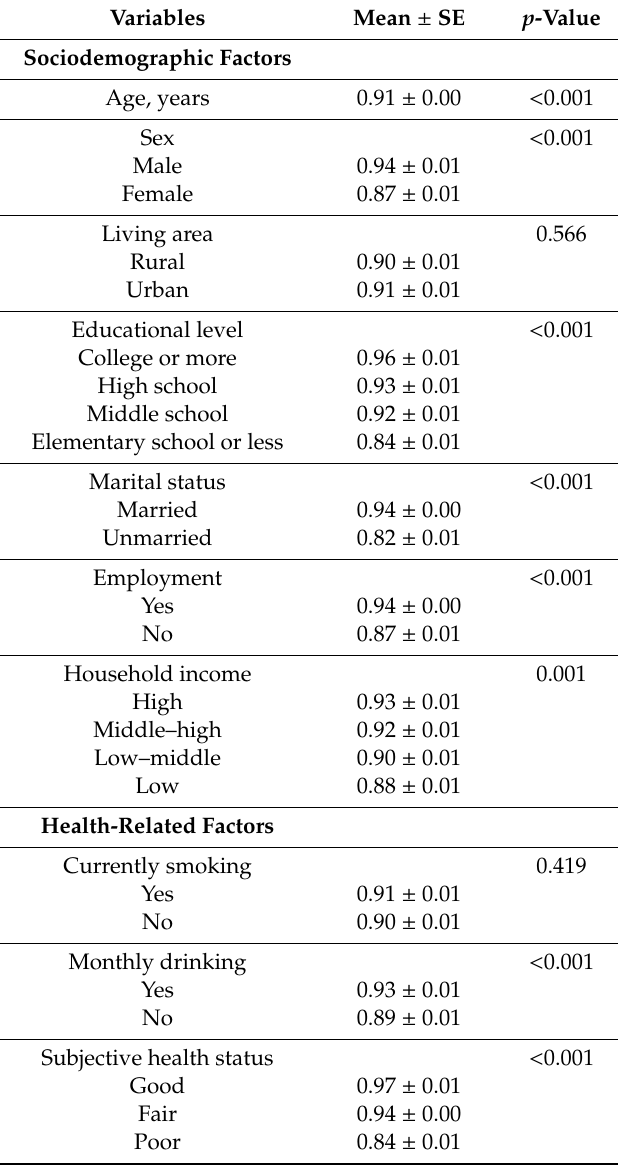
Table 2. Di ff erences in HRQoL by background characteristics ( n =